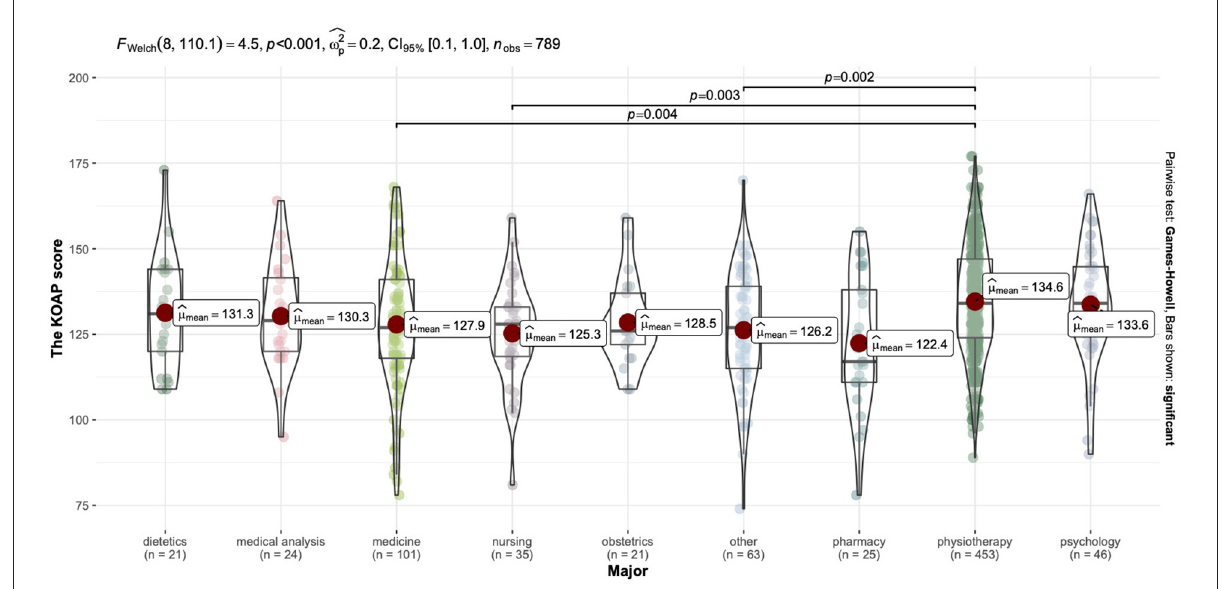
FIGURE3 Comparative characteristics of the KAOP mean scores grouped by major.